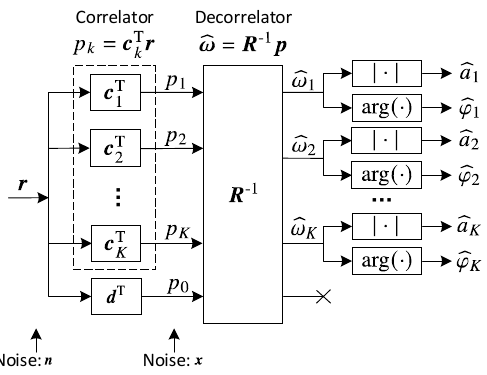
Figure 4. Structure of calibration receiver based on